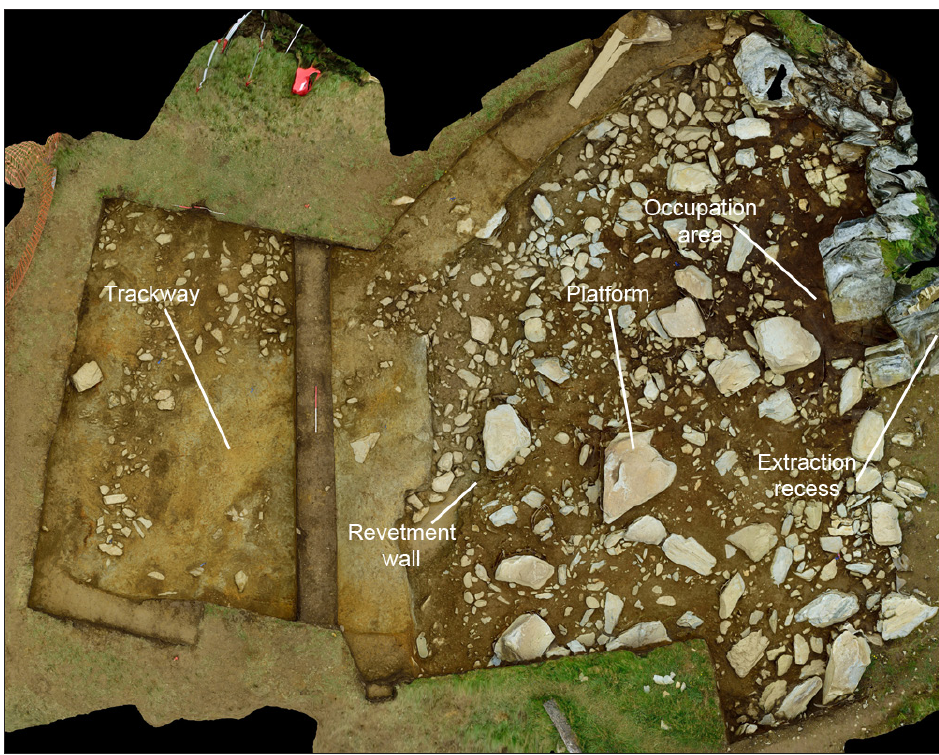
Figure 1: An aerial photogrammetric vertical view of excavations at Craig Rhos-y-felin show- ing the outcrop, the Neolithic platform and revetment wall, and the trackway; North is at the bottom left (Photo Adam